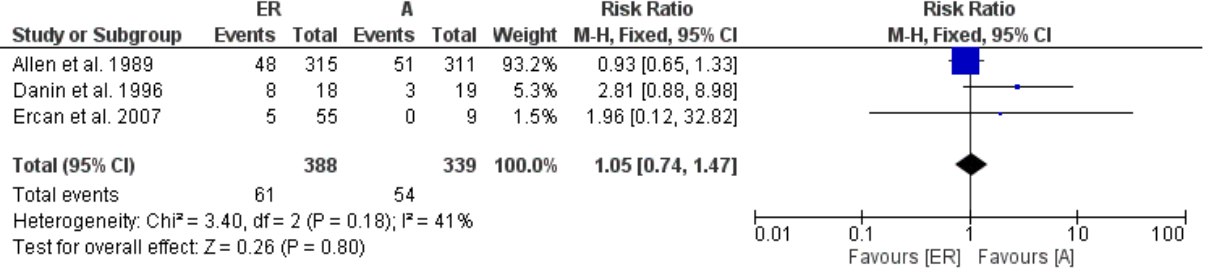
Figure 2. Forest plot of the fixed effects model of the meta-analysis; RR = 1.05, 95% CI: [0.74,1.47]; df = degrees of freedom; I 2 = Higgins heterogeneity index, I 2 < 50%, heterogeneity irrelevant; I 2 > 75%, significant heterogeneity; C.I. = confidence intervals; p = p value; ER = non-surgical endodontic re- treatment; A = surgical endodontic retreatments (apicoectomy) . The graph for each study shows the first author and the date of publication, Risk Ratio with confidence intervals, the number of failures for each type of retreatment, the number of non-surgical and surgical endodontic retreatments and the weight of each study expressed as a percentage. The final value was expressed in bold with the relative confidence intervals, the blue squares in the center of the confidence intervals represent the effect of the study in the meta-analysis and its size represents the weight of the study. The black line shows the position of the average value, and the rhombus in light black shows the measure of the average effect.